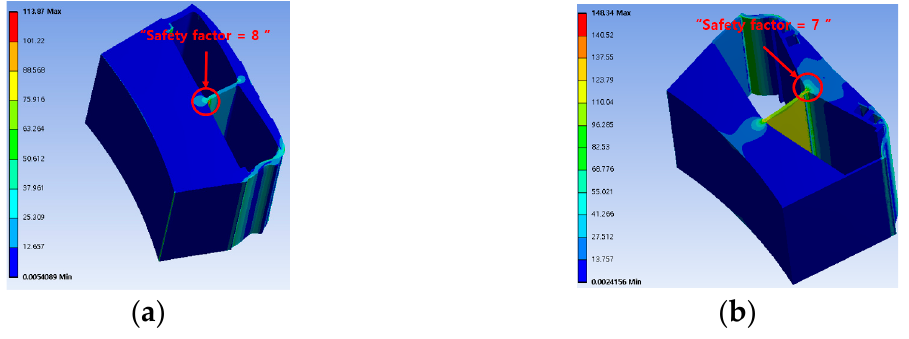
Figure 22. Rigidity comparison between the conventional model and final model: ( a ) Conventional model, ( b ) Final model.